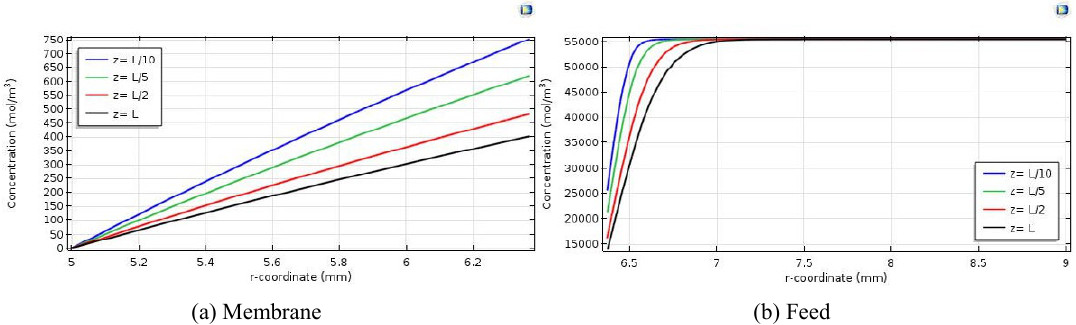
Fig. 8 Water concentration profile vs. r-coordinate at different membrane lengths (60 °C temperature, 1 bar pressure and 3 l/min feed flow rate)